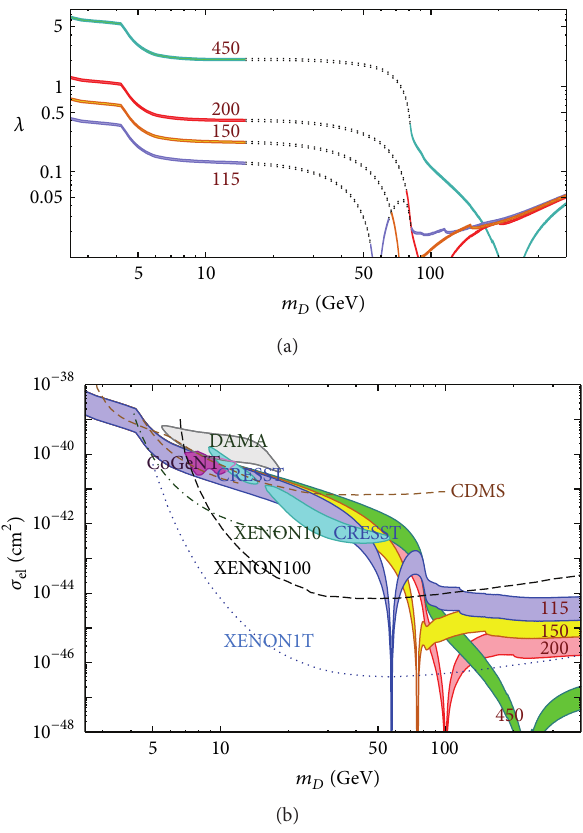
Figure 5: (a) Darkon-Higgs coupling 𝜆 as a function of darkon mass 𝑚 𝐷 for Higgs mass values 𝑚 ℎ = 115, 150, 200, 450 GeV in SM4+D. (b) The corresponding darkon-nucleon cross-section 𝜎 compared to 90%-CL upper limits from CDMS (brown long-dashed curves) [114, 115], XENON10 (green dot-dashed curve) [116], and XENON100 (black short-dashed curve) [110], as well as a (gray) patch compatible with the DAMA modulation signal at the 5 𝜎 level [117], the 90%-CL (magenta) signal region suggested by CoGeNT [31], and two 2𝜎 -confidence (cyan) areas representing the CRESST- II result [118]. Also plotted is the projected sensitivity of XENON1T (blue dotted curve) [119]. The black-dotted parts of the curves in (a) are ruled out by the direct search limits in (b) as discussed in the